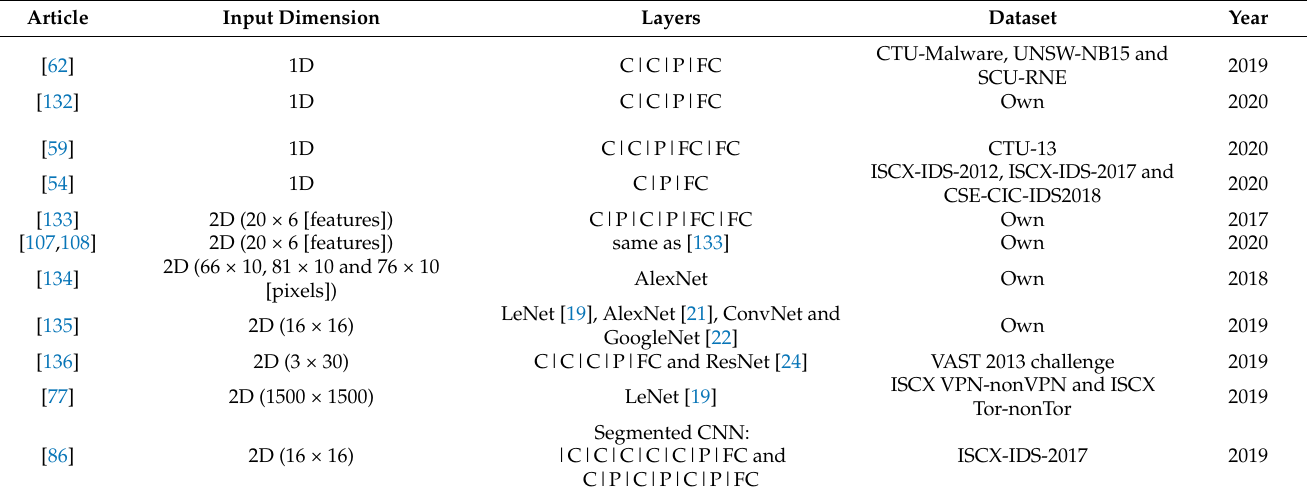
Table 8. Extracting features